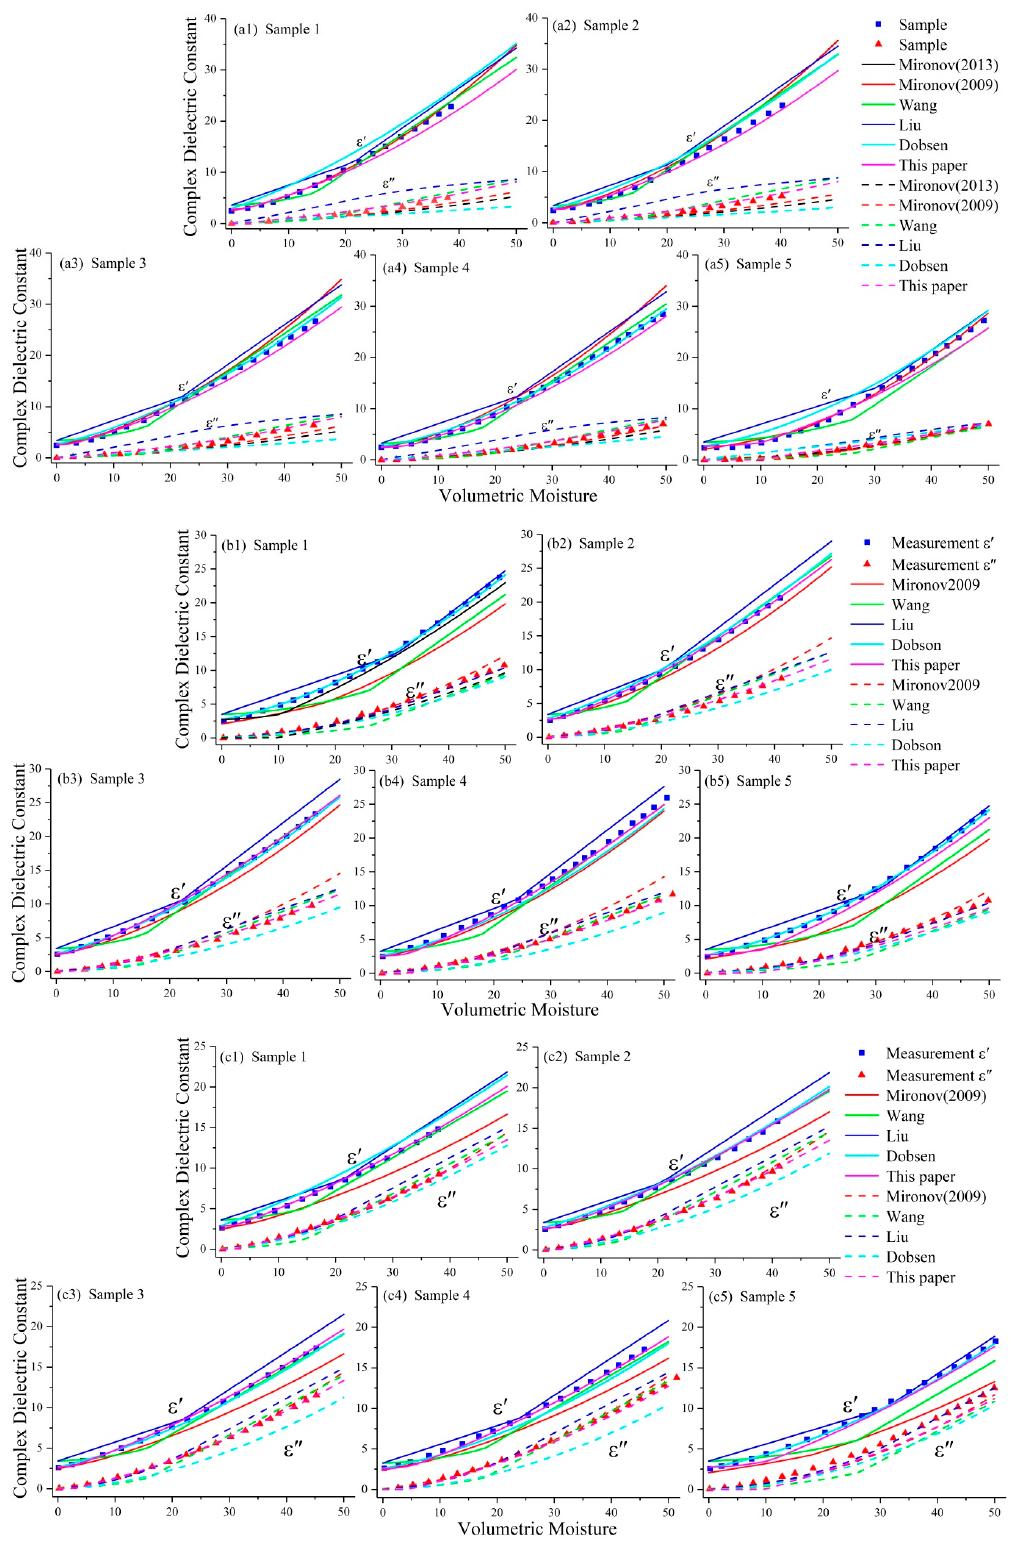
Figure 8. Comparison of the results of different complex dielectric constant models in the moisture range of 0-50% at ( a1 – a5 ) 1.4 GHz, ( b1 – b5 ) 10 GHz and ( c1 – c5 ) 18 GHz. Model of Mironov2013 [14] is a single frequency model at 1.4 GHz. Models of Mironov2009, Wang, Liu, and Dobson are from [5,10,13,15], respectively. In the model of Wang, we used 8% salt solution instead of free water. Table 3. ARMSEs of experimental values and calculated values. The bold of Soil No. 1–5 represents five types of in Table 1.